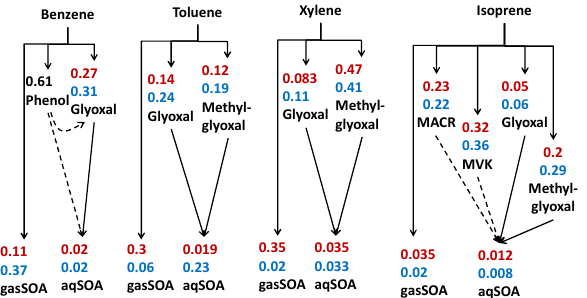
Fig. 6. Comparison of gasSOA and aqSOA yields from various precursors in the presence of [OH] = 10 6 cm − 3 over 12h. GasSOA yields are based on smog chamber experiments under low (red)/high (blue) NO x conditions and are calculated for an assumed organic aerosol mass of 10µgm − 3 . AqSOA yields are derived from box model studies using kinetic data (Tables 1 and 2, data with ∗ ) and are derived for 20µgm − 3 aerosol